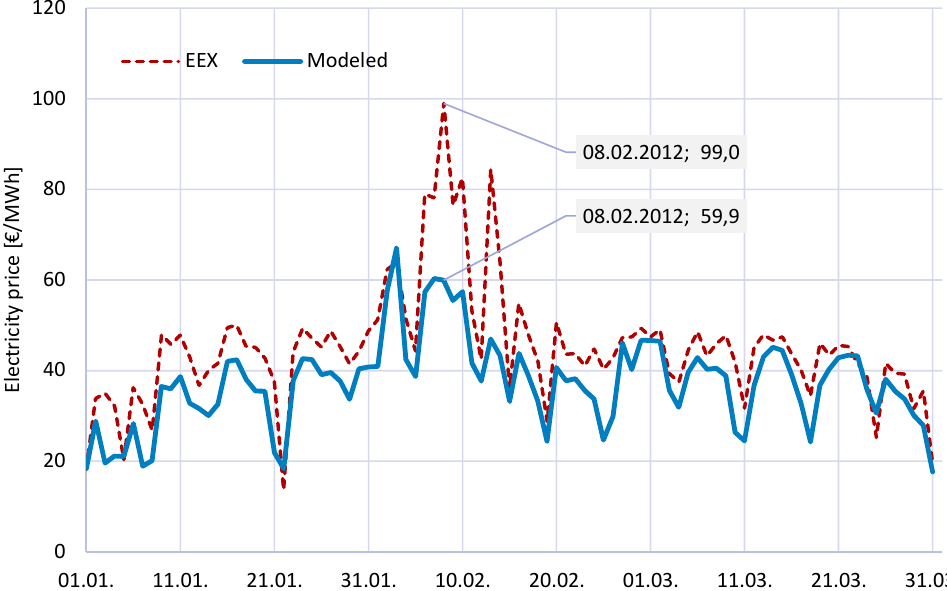
Figure 7. Average daily historical vs. simulated electricity prices for January-March 2012.